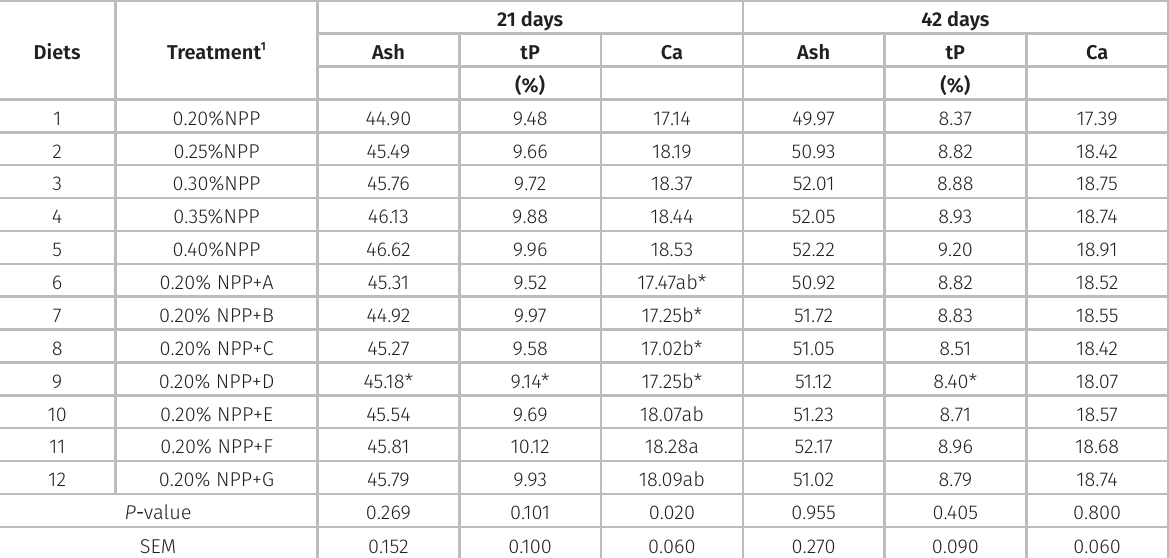
Table III. Summarized results for ash, calcium (Ca) and total phosphorus (tP) from tibia bone of broilers at 21 and 42 days of